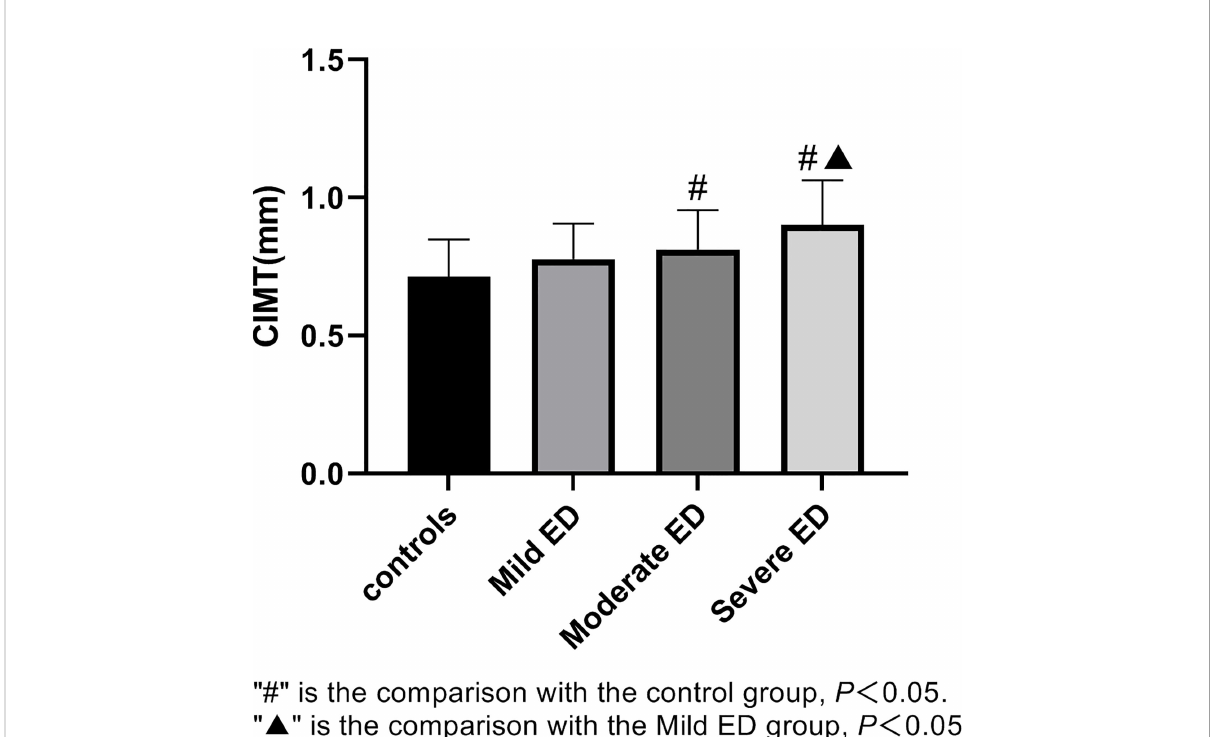
FIGURE 2 CIMT values in healthy controls, mild ED, moderate ED, Severe ED. "#" is the comparison with the control group, P<0.05. " ▲ " is the comparison with the Mild ED group,